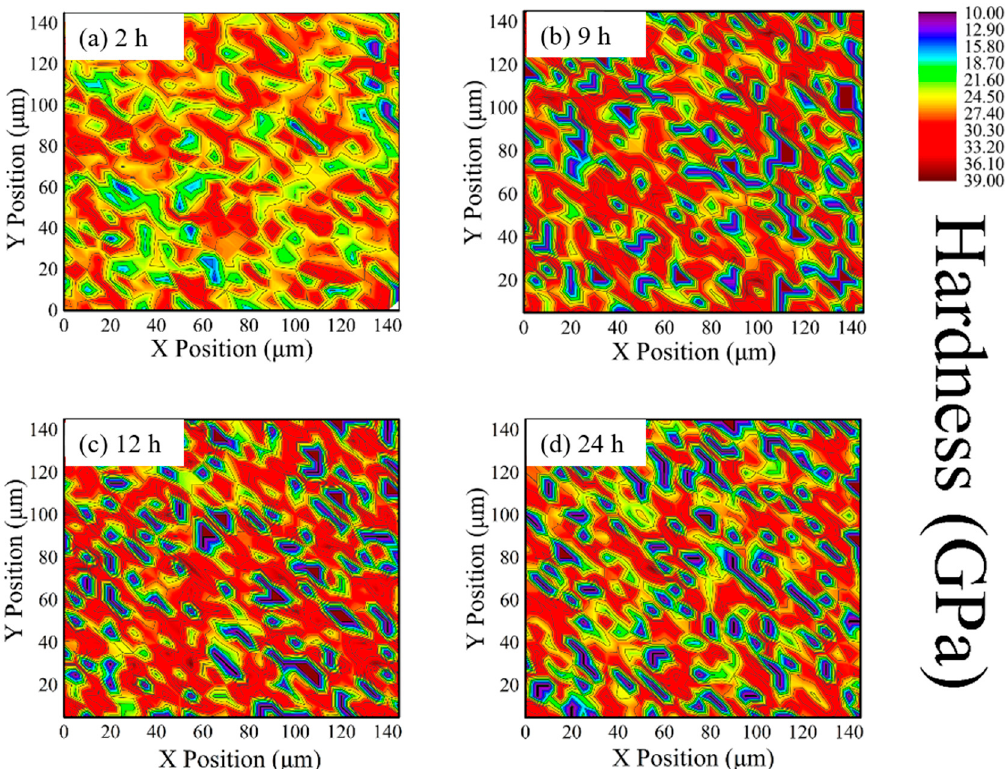
Figure 3. Plane projections of the hardness of 8YSZ with the annealing time ( a ) 2 h, ( b ) 9 h, ( c ) 12 h, ( d ) 24 h. The right color scale indicates hardness variation.